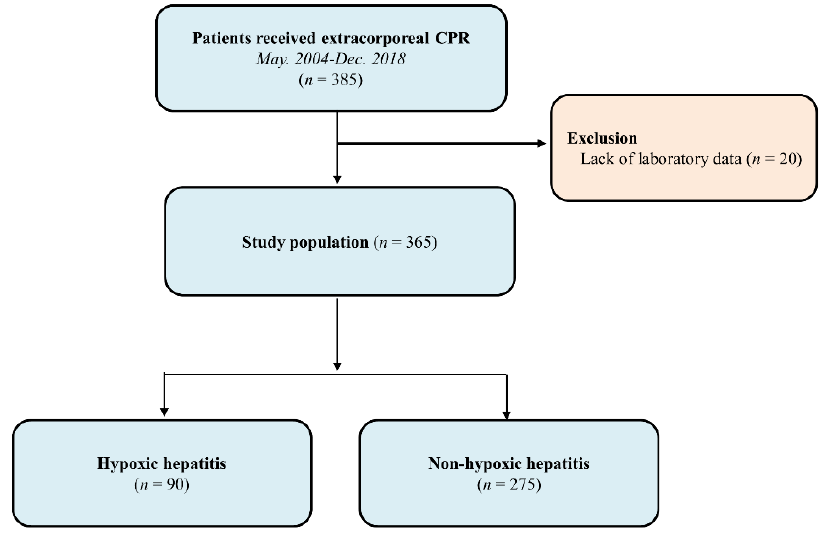
Figure 1. Study flow chart.